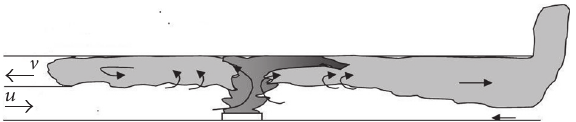
Figure 1: Illustration of the back-layer velocity ( V ) opposite to the ventilation velocity ( 𝑢 ).